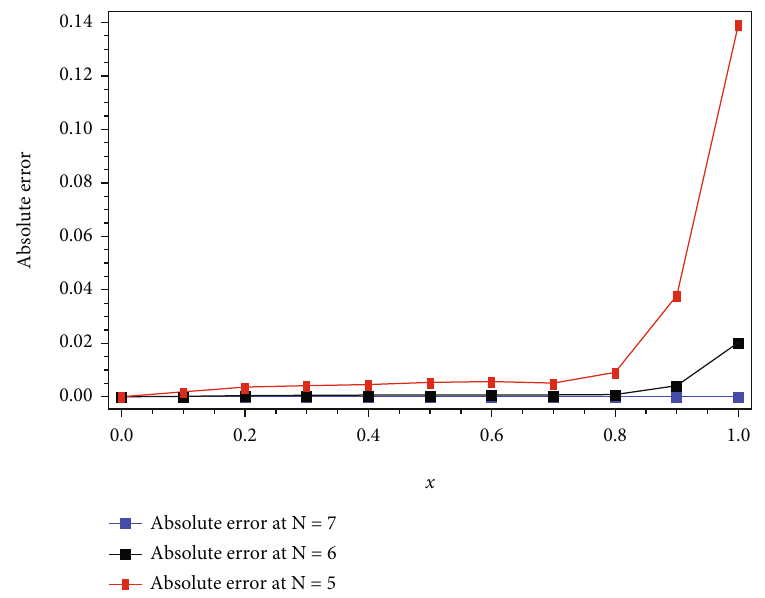
Figure 4: The absolute error when h = 1 for three di ff erent values of N for Example